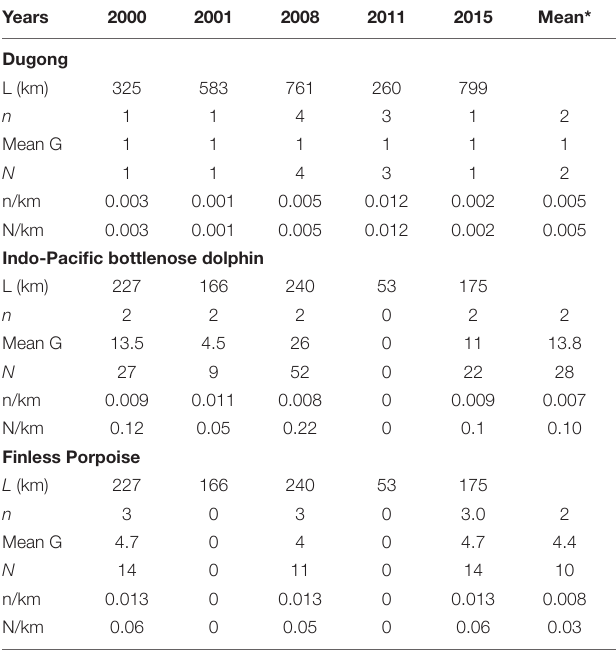
TABLE 5 | Sighting and individual encounter rates of other cetaceans in the outer Bay (A) and sirenians in segments inside the Bay (B South, B North and C).